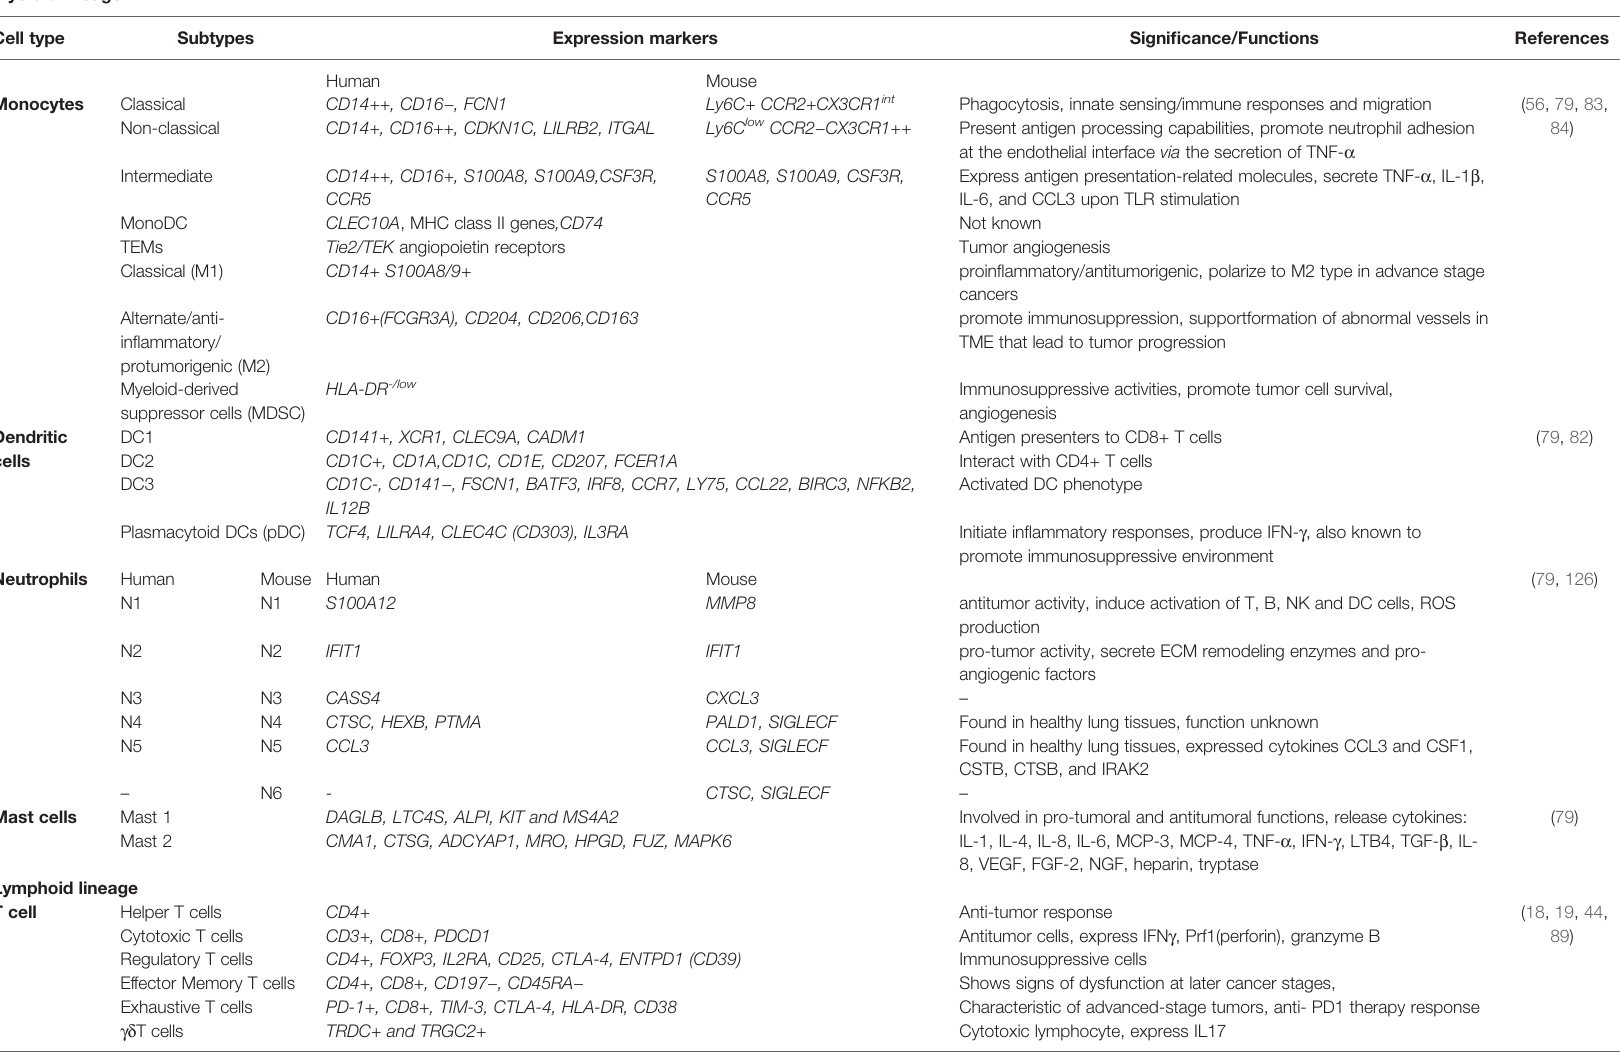
TABLE 4 | Distinct subsets of immune cells in human/mouse tumor